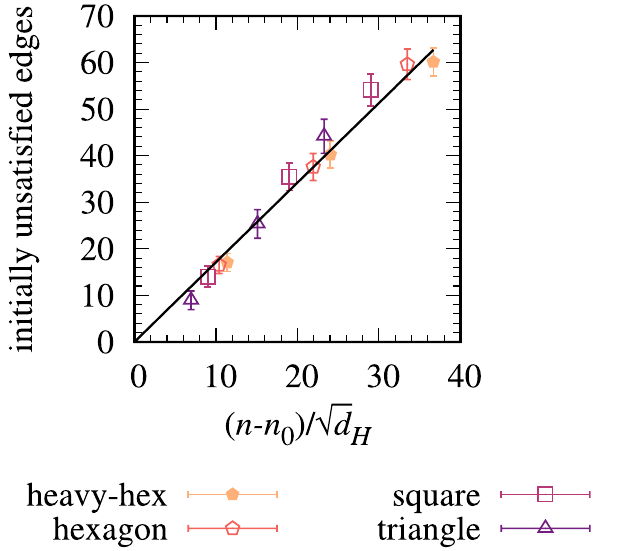
Figure 5. The number of initially unsatisfied edges N u in the initial qubit placement at each n and d H for 3-regular